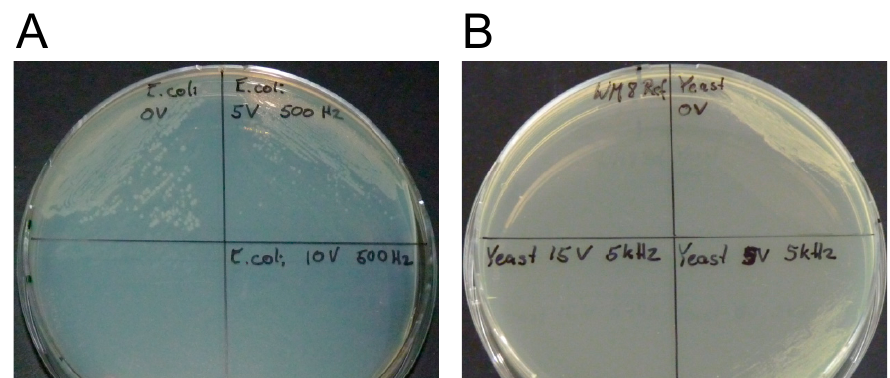
Figure 2. The influence of di ff erent applied electric field strengths on the viability of Escherichia coli ( A ) and Saccharomyces cerevisiae ( B ) shown from plating assay. For E. coli , the viability assay shows results after one day of plate incubation at 37 ◦ C of electroporated samples from the chip. Cells were found to have grown in the control experiment (0 kV / cm, top left ( A )) and the 5 kV / cm sample (top right ( A )) and no growth was observed in the 10 kV / cm sample (bottom right ( A )) indicating successful irreversible electroporation. For S. cerevisiae , the viability assay shows results after one day of plate incubation at 30 ◦ C of electroporated samples from the chip. Cells were found to have grown in the control experiment (0 kV / cm, top right ( B )) and the 2.5 kV / cm sample (bottom right ( B )) and no growth was